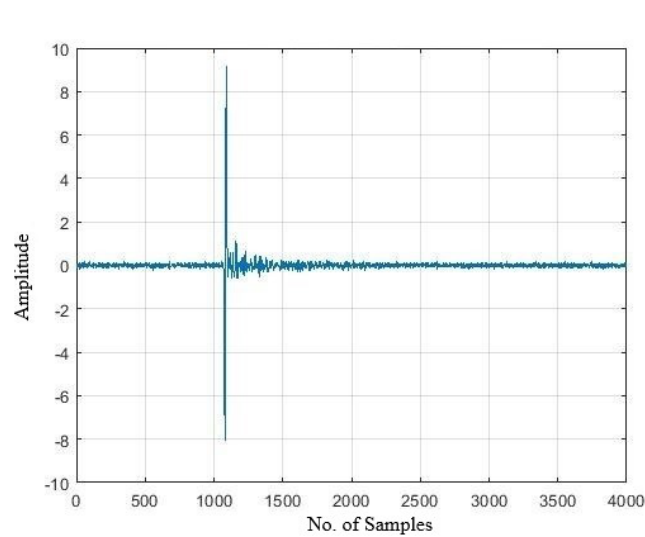
Figure 3. UWB pulse.